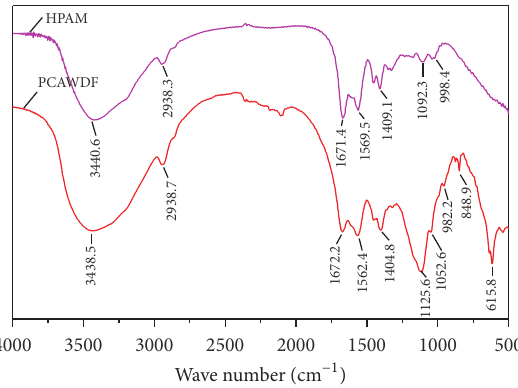
Figure 3: IR spectra of PCAWDF and